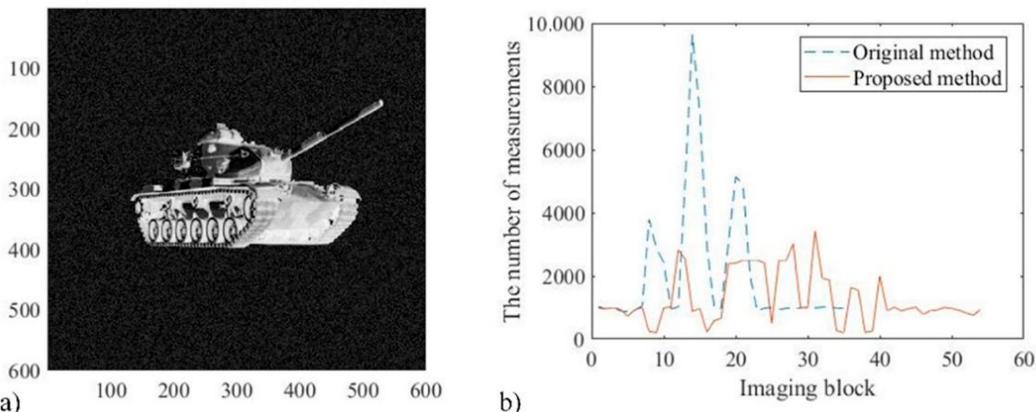
Figure 7. The intensity image of the target and the result of the comparison experiment.